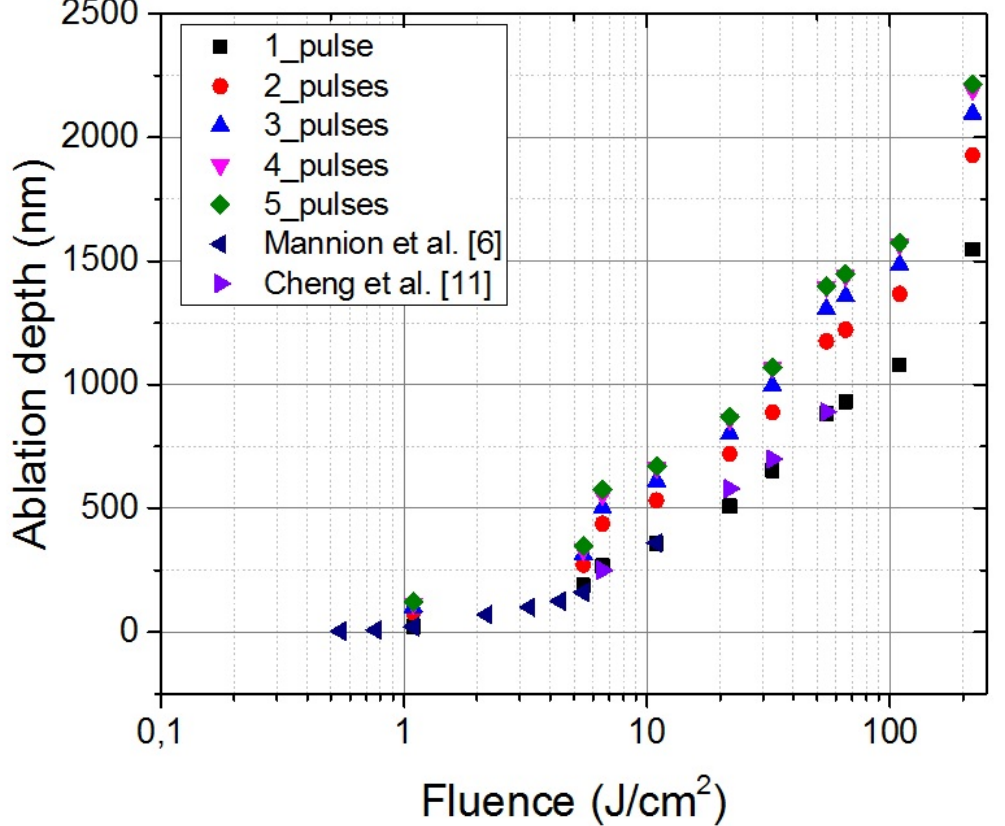
Figure 6. Simulation of ablation depth at different pulse numbers with t sep = 1.5 ps ( 2 rate), and experimental data for single-pulse ablation from Mannion et al. [6] and Cheng et al. [11].